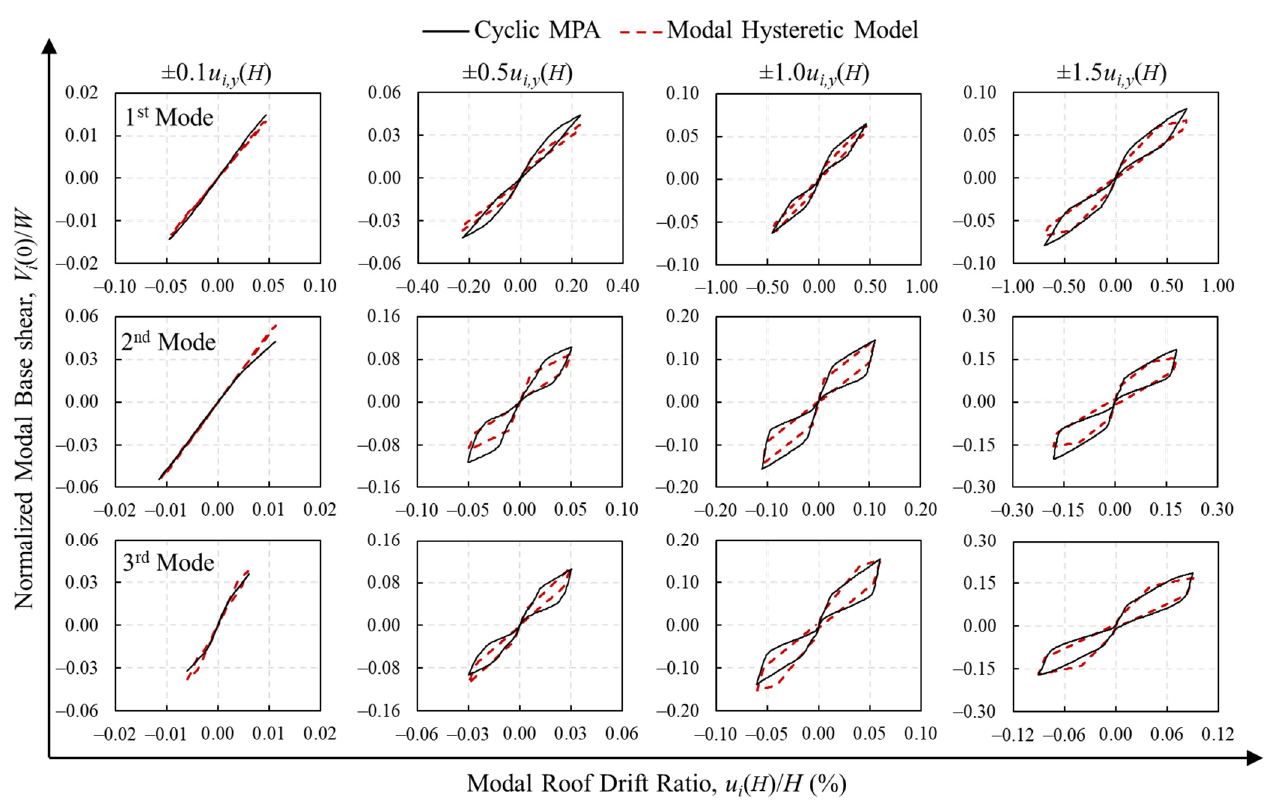
Figure 14. Modal hysteretic responses of building B2 in the first, second, and third modes in the x direction.